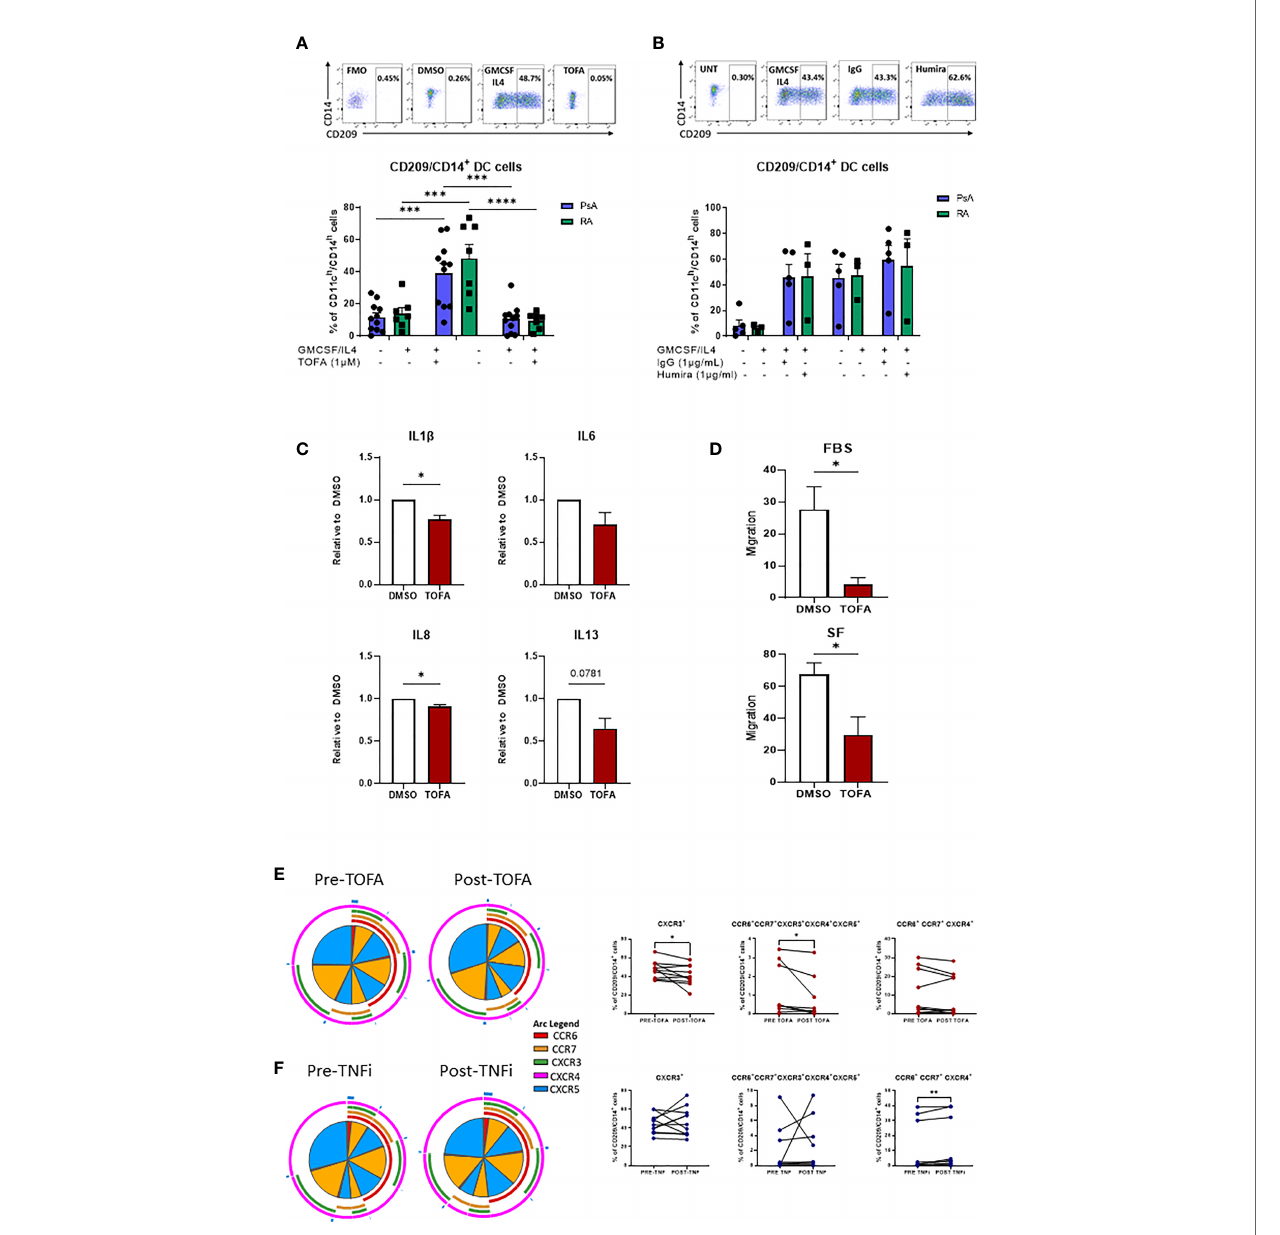
FIGURE 5 | Therapeutic targeting the CD209/CD14 + DC population. (A) Lineage negative population from PsA (n=11) and RA (n=7) patients treated 15 ’ with DMSO/Tofacitinib (1uM) prior to the stimulation with the GMCSF/IL4 cocktail. Top, representative fl ow plot; bottom histograms. (B) Lineage negative population from PsA (n=5) and RA (n=3) patients treated 15 ’ with IgG/Humira (1ug/mL) prior to the stimulation with the GMCSF/IL4 cocktail. Top, representative fl ow plot; bottom histograms. Data are represented as mean ± SEM and differences among groups were evaluated by two-way ANOVA with Tukey post-test. *p < 0.05, **p < 0.01, ***p < 0.001, ****p < 0.0001. (C) Multiplex MSD analysis of IL1 b , IL6, IL8, IL13 from CD209 + DC supernatant of IA (n=7) patients treated over-night with DMSO/ Tofacitinib (1µM). Data are represented as ratio of expression toward control (DMSO) ± SEM and differences among groups were evaluated by paired t-test *p < 0.05, **p < 0.01. (D) Migration analysis of CD209 + DC from IA (n=3) patients treated over-night with DMSO/Tofacitinib (1µM). Histograms display the migration ratio toward 2% FBS or 20% SFMC paired supernatants, between the bottom of the well and the total cell count as described in the methods. differences among groups were evaluated by paired t test. *p < 0.05. E-F) PBMC from patients before and after (E) Tofacitinib treatment (n=10) or (F) TNF inhibitor (TNFi) treatment (n=11). Left, SPICE algorithm fl ow cytometric analysis displaying the frequency of the chemokines receptors (shown as frequency of parent) CCR6 (red arc), CCR7 (yellow arc), CXCR3 (green arc), CXCR4 (light blue arc) and CXCR5 (dark blue arc) and right, corresponding trending lines for chemokine receptors expressing alone or in combination. Differences among groups were evaluated by paired t